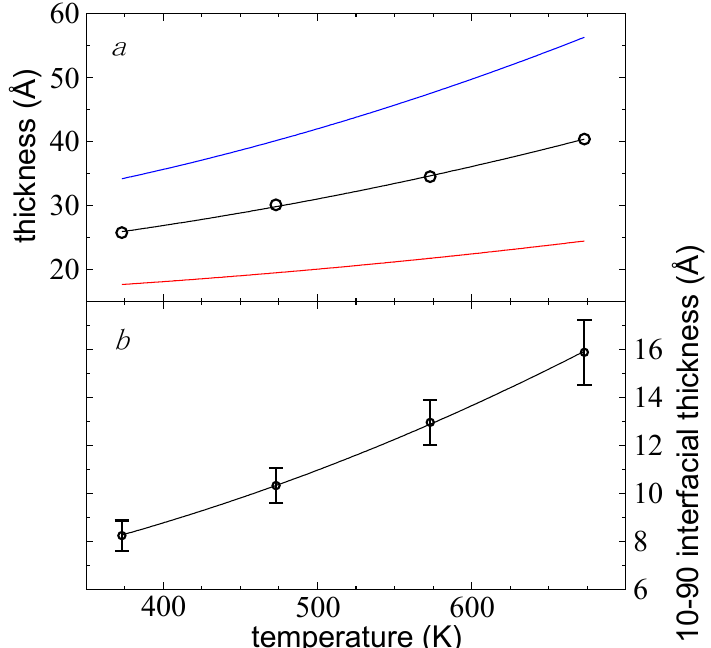
Figure 8. ( a ) t Gds (black circles) of thin liquid layers of melted polyethylene chains (C 200 ) in a liquid– vacuum equilibrium as a function of T . Standard deviations are smaller than the symbols. The black line represents the adjustment to a quadratic function on T . ( b ) t i (black circles) as a function of T . The solid line represents the adjustment to a quadratic function on T . The bars represent standard deviations of the measurements. Red and blue lines in ( a ) represent t Gds − t i and t Gds + t i , respec- tively.